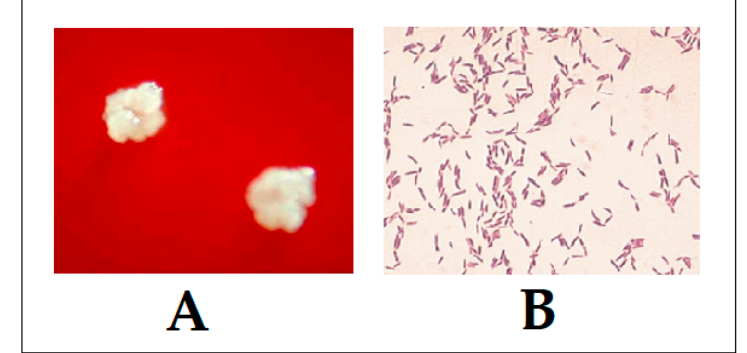
Figure 2. Typical colony morphology ( A ) and Gram-staining ( B ) of A. bovis.